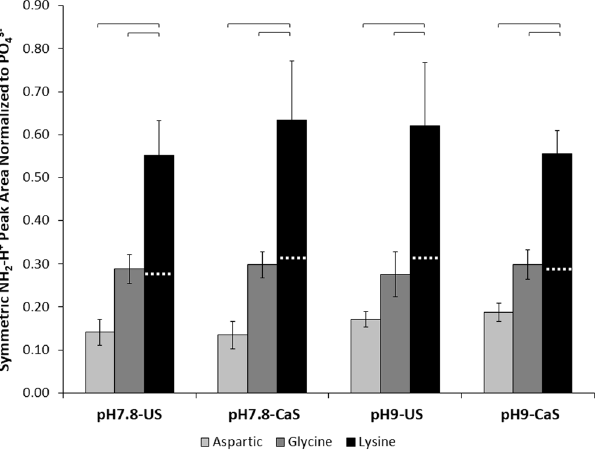
Figure 4. ATR-FTIR analysis of the amino acid functionalized ns-nHA NH 2 -H + peak area normalized to PO 43 − peak area. Lysine-functionalized ns-nHA was found to have the greatest symmetric NH 2 -H + peak area. However, there are two NH 2 -H + groups per lysine molecule (aspartic acid and glycine only have one NH 2 -H + group per molecule). As shown by the white horizontal dashed line on the lysine column, the NH 2 -H + peak area analysis suggests that there is a comparable amount of lysine attached to the ns-nHA surface as glycine. Data reported as average ± one standard deviation (n = 3). ns-nHA unsaturated with calcium is given as US, while that pre-saturated with calcium is given as CaS. Horizontal bars indicate statistically detectable difference (p <